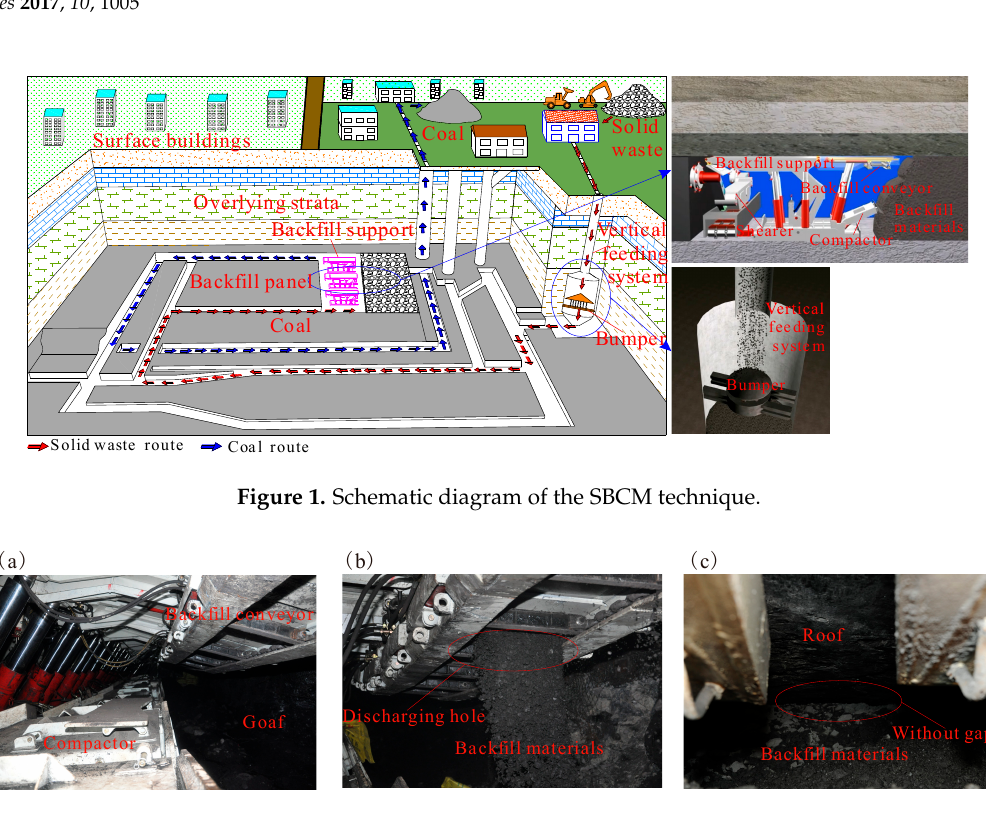
Figure 2. Photographs for underground backfill: ( a ) backfill support; ( b ) backfill conveyor; and ( c ) no gap with roof.